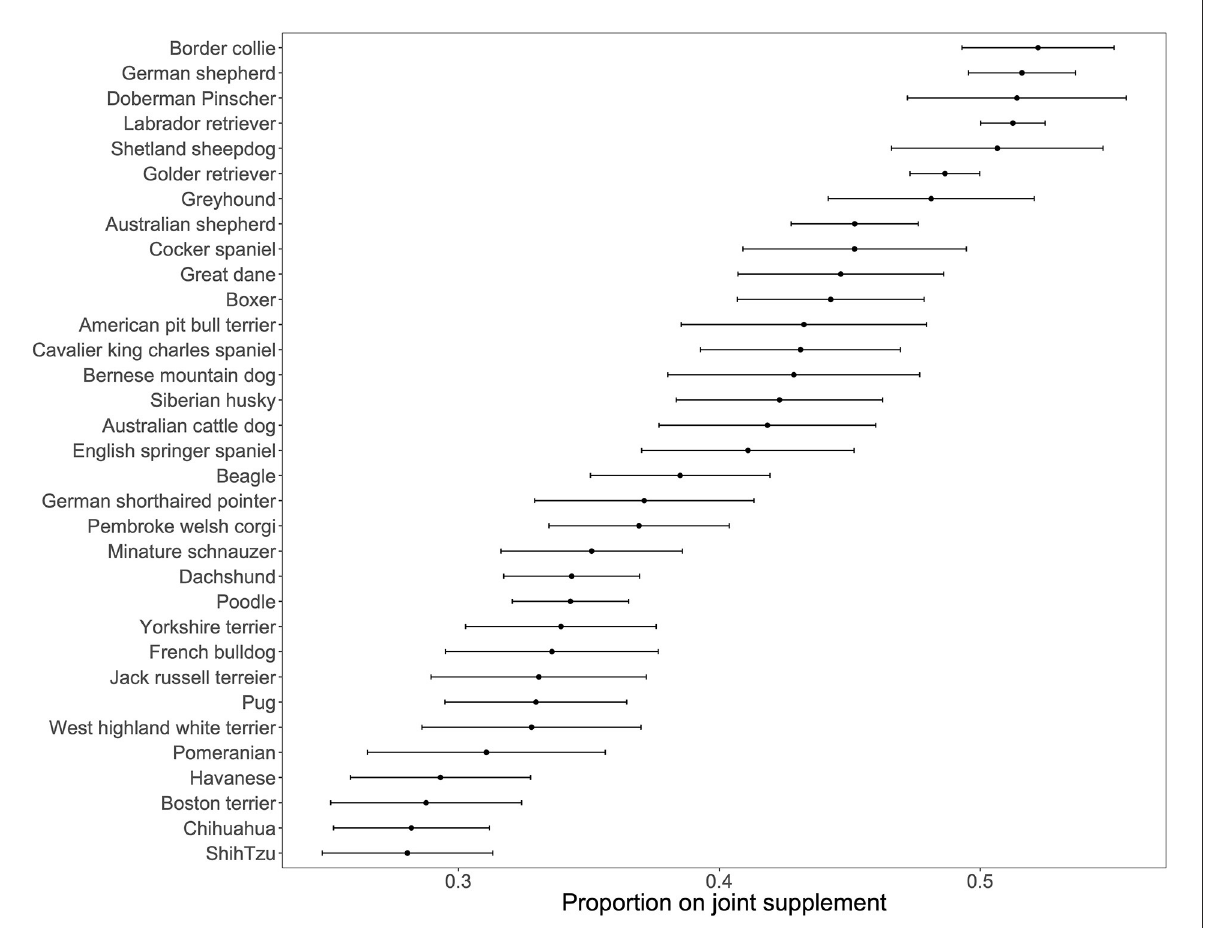
FIGURE3 Proportion of individual breeds on a joint supplement. N = 33 breeds with over 100 dogs. Error bars denote standard errors of a